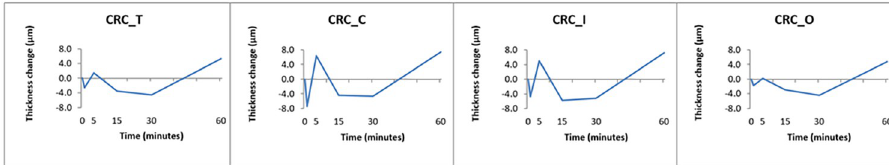
Fig 7. Changes observed in the choroid over time following vita maxima strain of the study participants. The changes were not statistically significant (from left to right, macular area (T), central subfield (C), inner (I) and outer rings(O)). For mean and SD values see S4 Table. (For the abbreviations of the layers see Fig